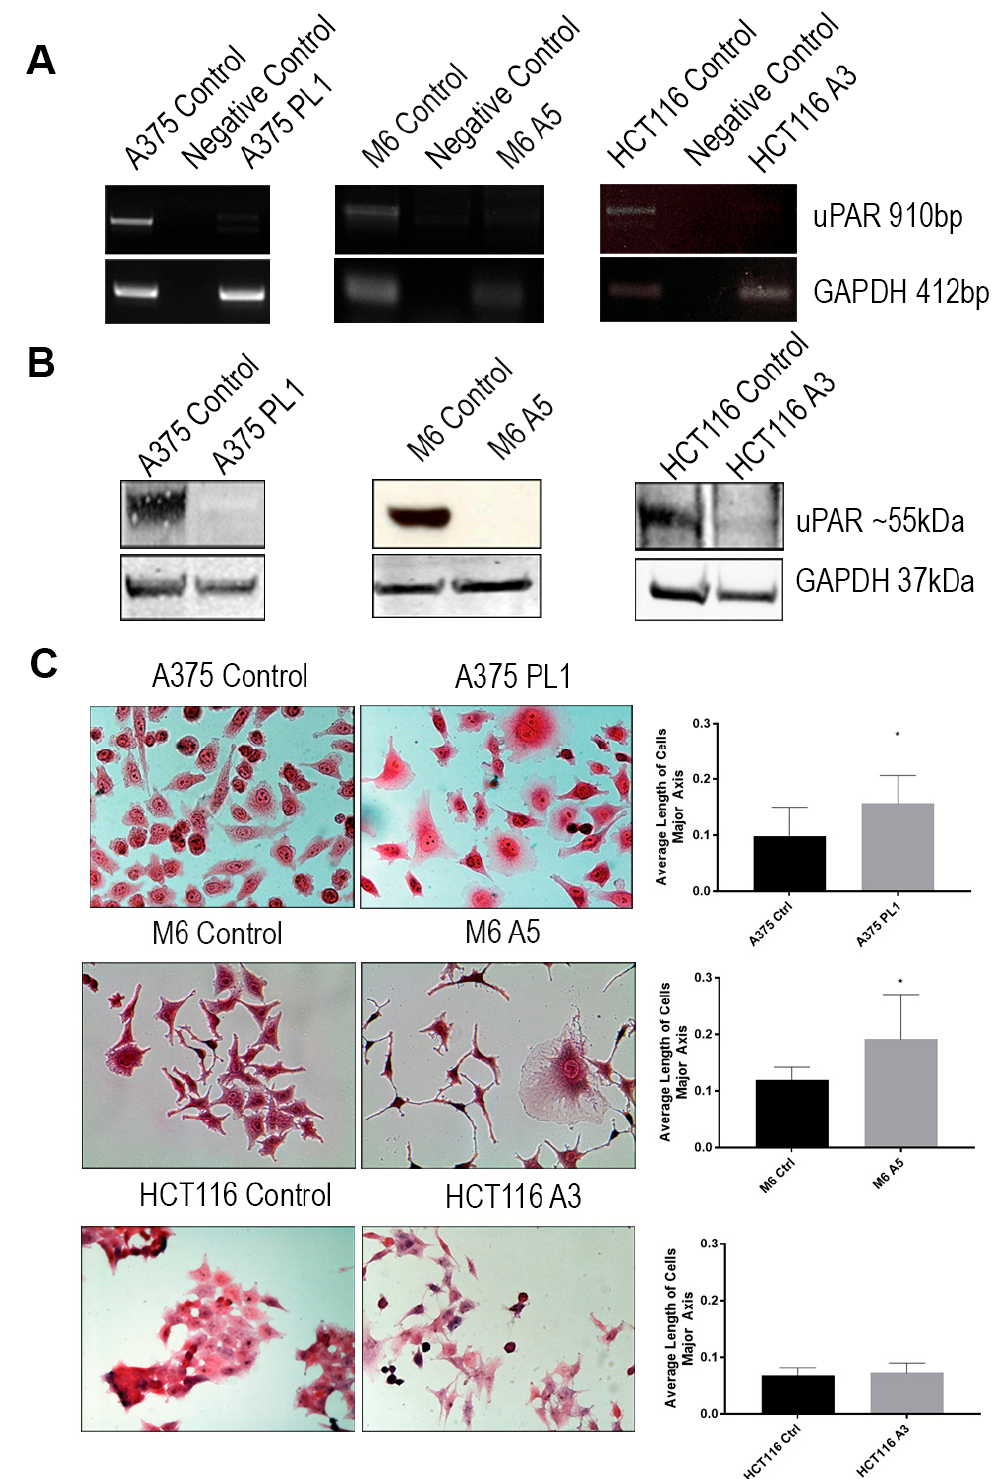
Figure 2. ( A ) Total RNA isolated was subjected to Reverse Transcriptase-PCR analysis of PLAUR expression, and GAPDH was used as a loading control ( n = 3). ( B ) Whole cell lysates were analyzed by Western Blot for uPAR expression, and GAPDH was used as a loading control ( n = 3). ( C ) Images of Control and uPAR KO cells 2 weeks after transfection. Cells were fixed and stained with Hematoxylin and Eosin. Images were captured at 10× magnification and the cells major axis was analyzed by ImageJ ( n = 15) Data are presented as mean ± SD. * p < 0.01 (Student’s test).